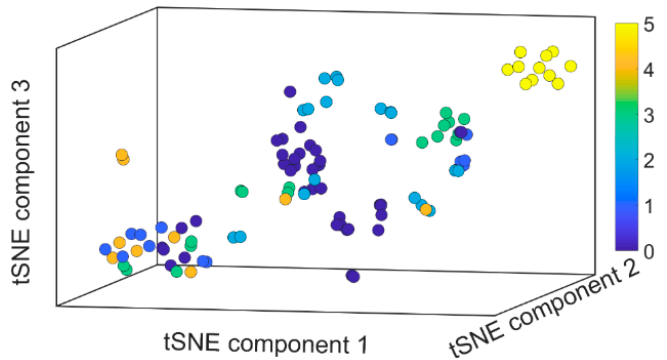
Figure 3. 3-dimensional t-SNE visualization of the result of air component experiment validation set in activation space representation. Class 0 to 4 represent acetone, ethanol, chloroform, toluene, methanol, respectively. Finally, class 5 represents a new undefined ingredient apart from the defined five types of ingredients.